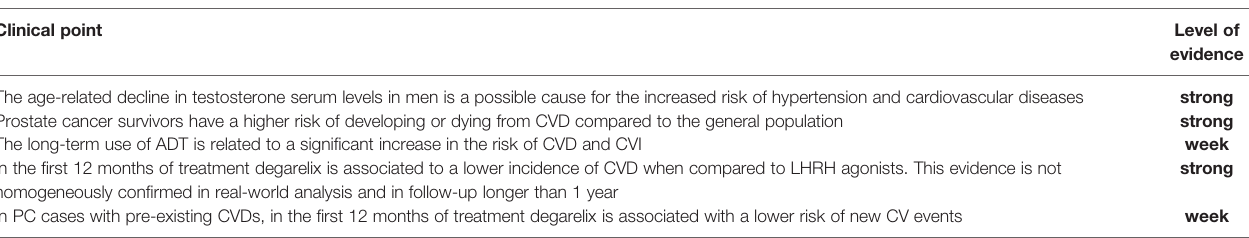
TABLE 3 | Clinical